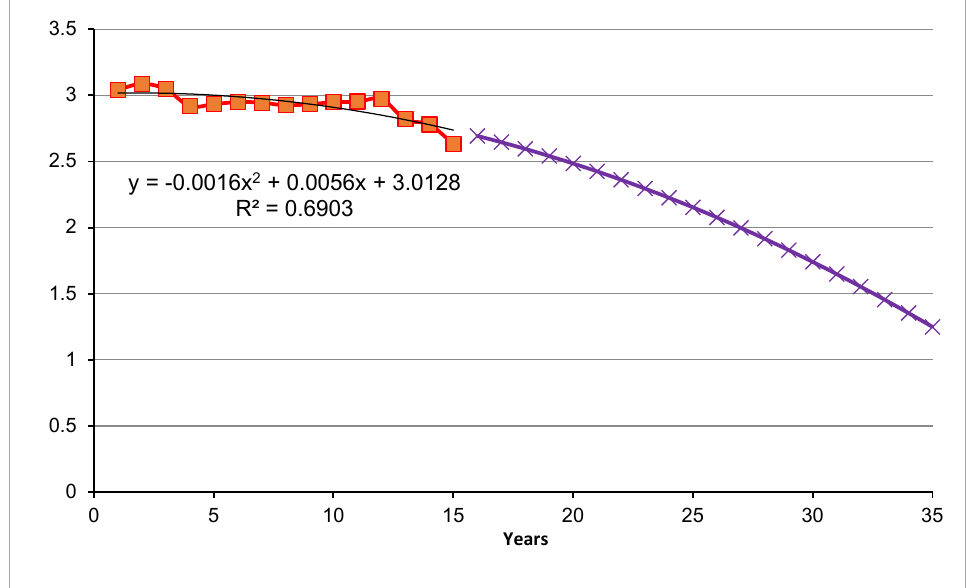
Figure 2. Relation between the number of contributors and beneficiaries of the Polish pension insurance system (2006–2040) * . *—year 1 is 2006, year 35 is 2040. Source: Own calculations based on Statistical Yearbook of Social Insurance.